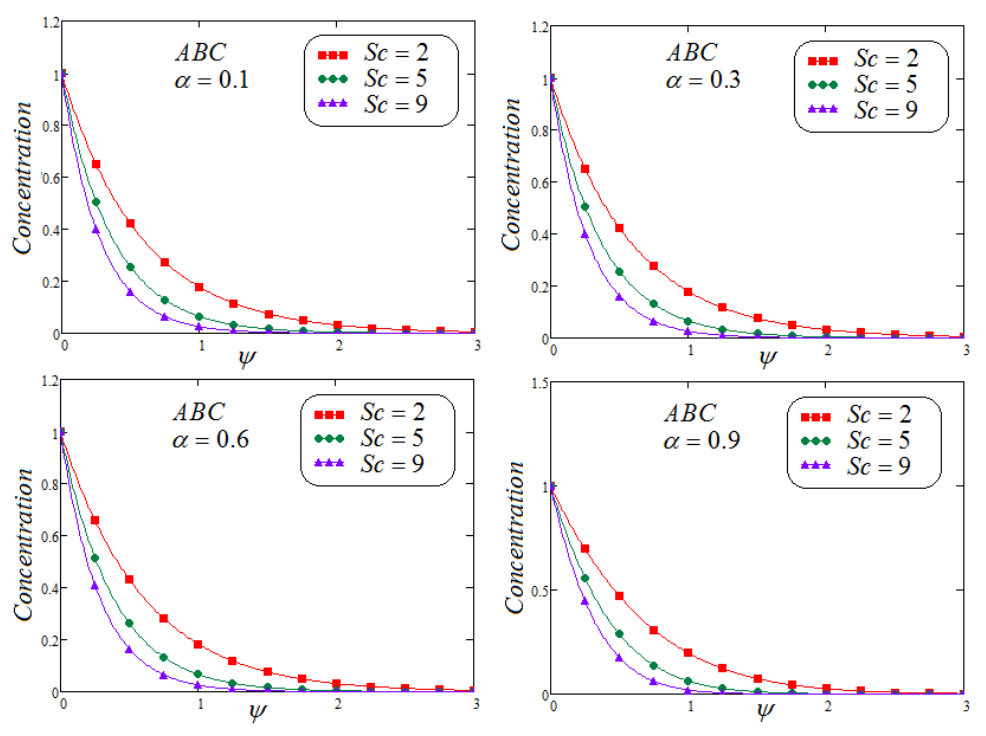
Figure 4. Trace of dimensionless concentration for dissimilar values of Sc via